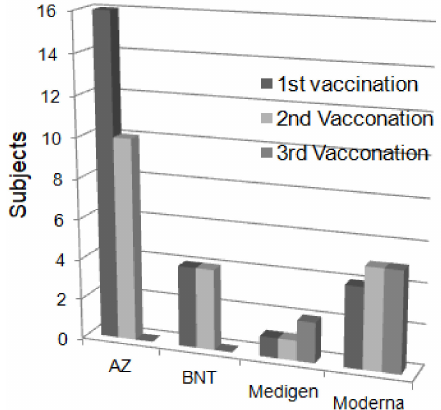
Figure 6. Distribution of vaccine brands received by